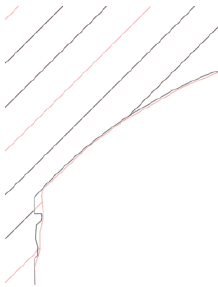
Figure 2 Deviation map for NavVis point cloud